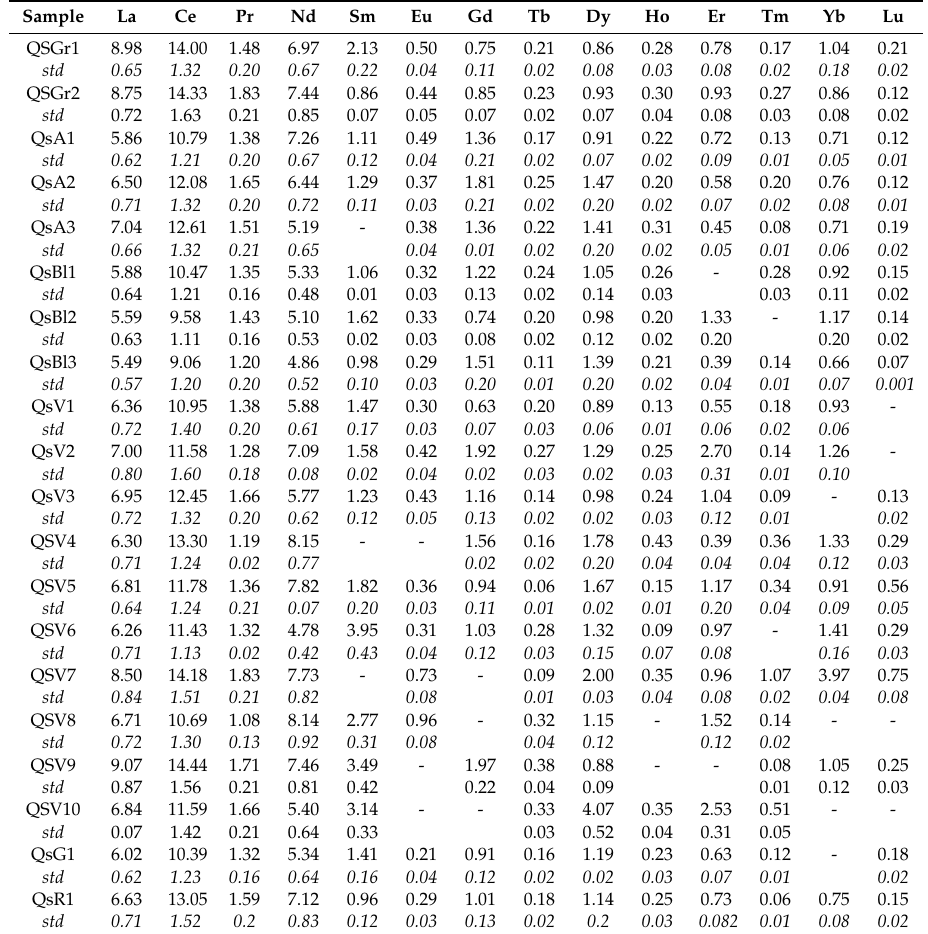
Table 5. Rare Earth Element concentrations in ppm determined by